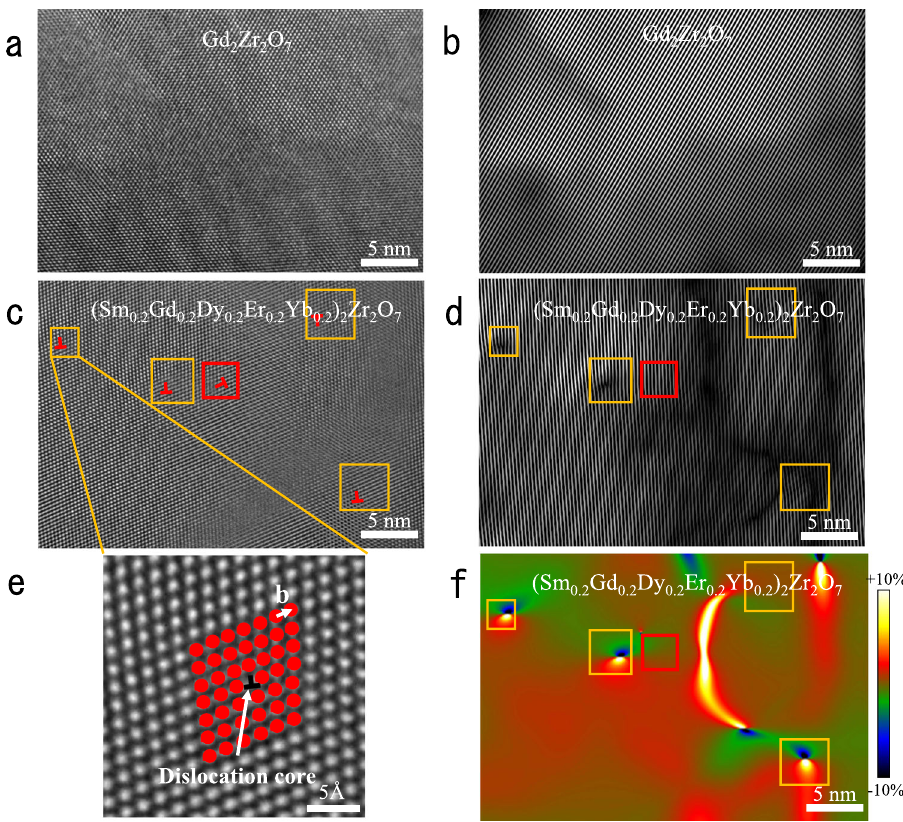
Fig. 1 High-resolution characterization of Gd 2 Zr 2 O 7 and high-entropy fl uorite oxide (HEFO, (Sm 0.2 Gd 0.2 Dy 0.2 Er 0.2 Yb 0.2 ) 2 Zr 2 O 7 ) with edge dislocations and strain distribution. a High-resolution transmission electron microscope (HRTEM) graph of Gd 2 Zr 2 O 7 ; b The inverse fast Fourier transform (IFFT) fi ltered image of Gd fl uorite oxide; d The inverse fast Fourier 2 Zr 2 O 7 shows perfect periodicity without dislocations; c HRTEM graph of high-entropy transform (FFT) fi ltered image of high-entropy fl uorite oxides; e HRTEM graph of single edge dislocation; f Geometric Phase Analysis (GPA) mapping of a calculated by Digital Micrograph, showing an overall strain fi eld at nanoscale. The color scale represents change in strain intensity from − 10% (compressive) to 10% (tensile). The yellow and red squares mark the area around the